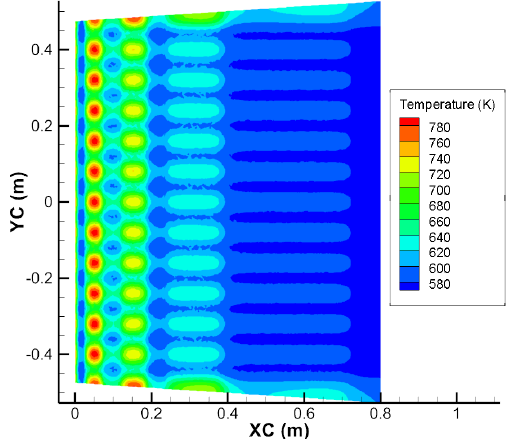
Figure 8. The temperature contour of XC–YC cross-section.